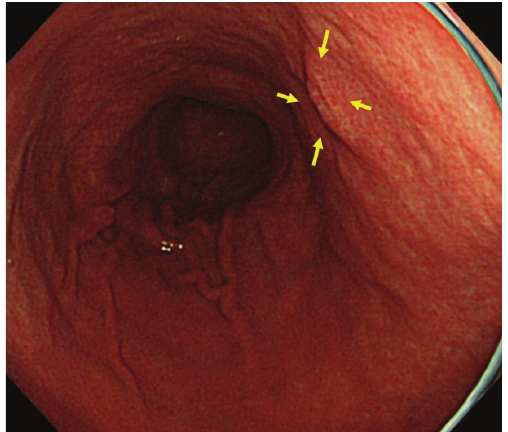
Figure 2: Endoscopic image of a patient in group P showing a flat elevated lesion on the posterior wall of the middle gastric body (yellow